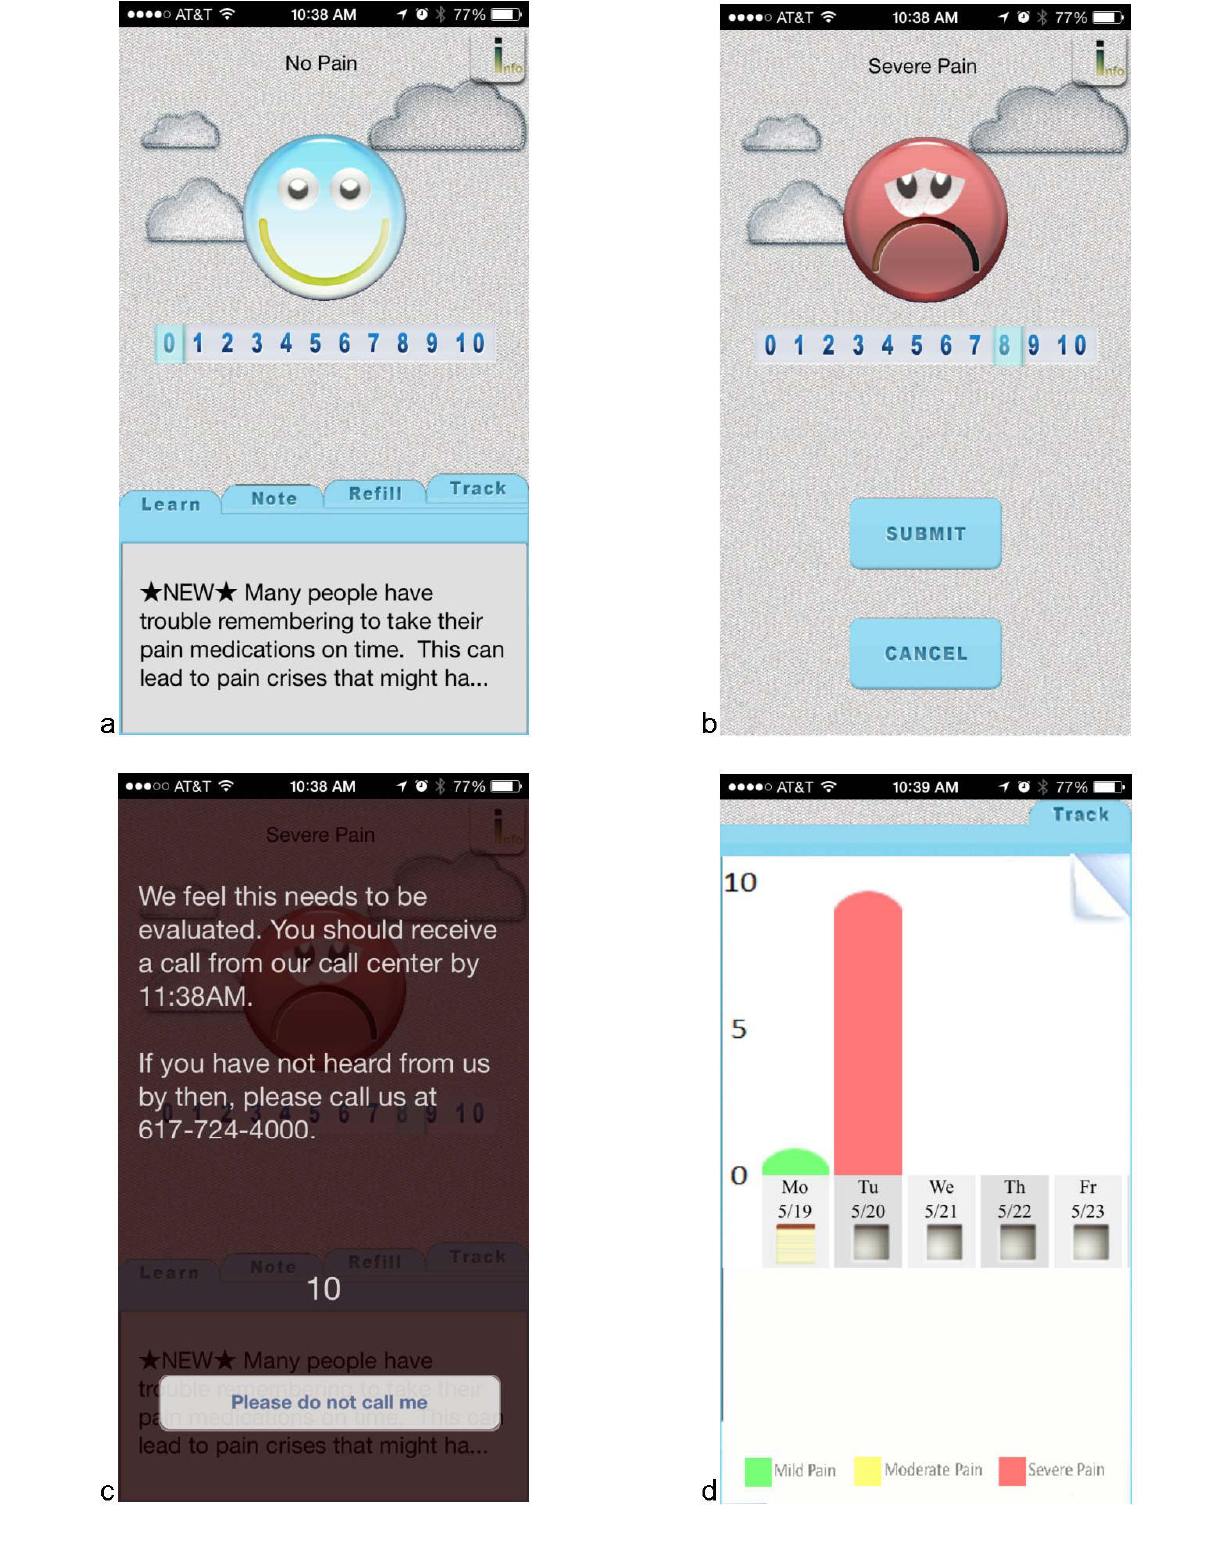
Figure 2. ePAL Mobile Application. a-d shows the numerical rating scale and pain tracking feature: a). Welcome page with educational tip; b & c). NRS and resulting message if pain score >8; d). Trend of pain scores, with